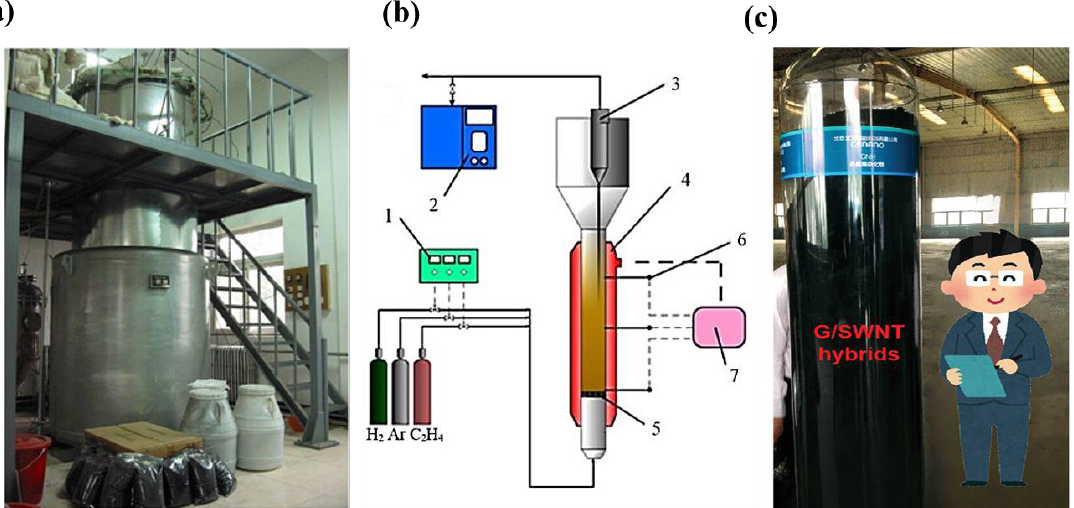
Figure 3. ( a , b ) Schematic illustration of the large-scale fabrication of CNTs by a fluidized-bed reactor. Reproduced with permission from [41] . Copyright 2008, Elsevier. ( c ) The photo of collected CNTs and graphene hybrids in mass production. Reproduced with permission from [45] . Copyright 2021, Wiley-Vch Verlag Gmbh.